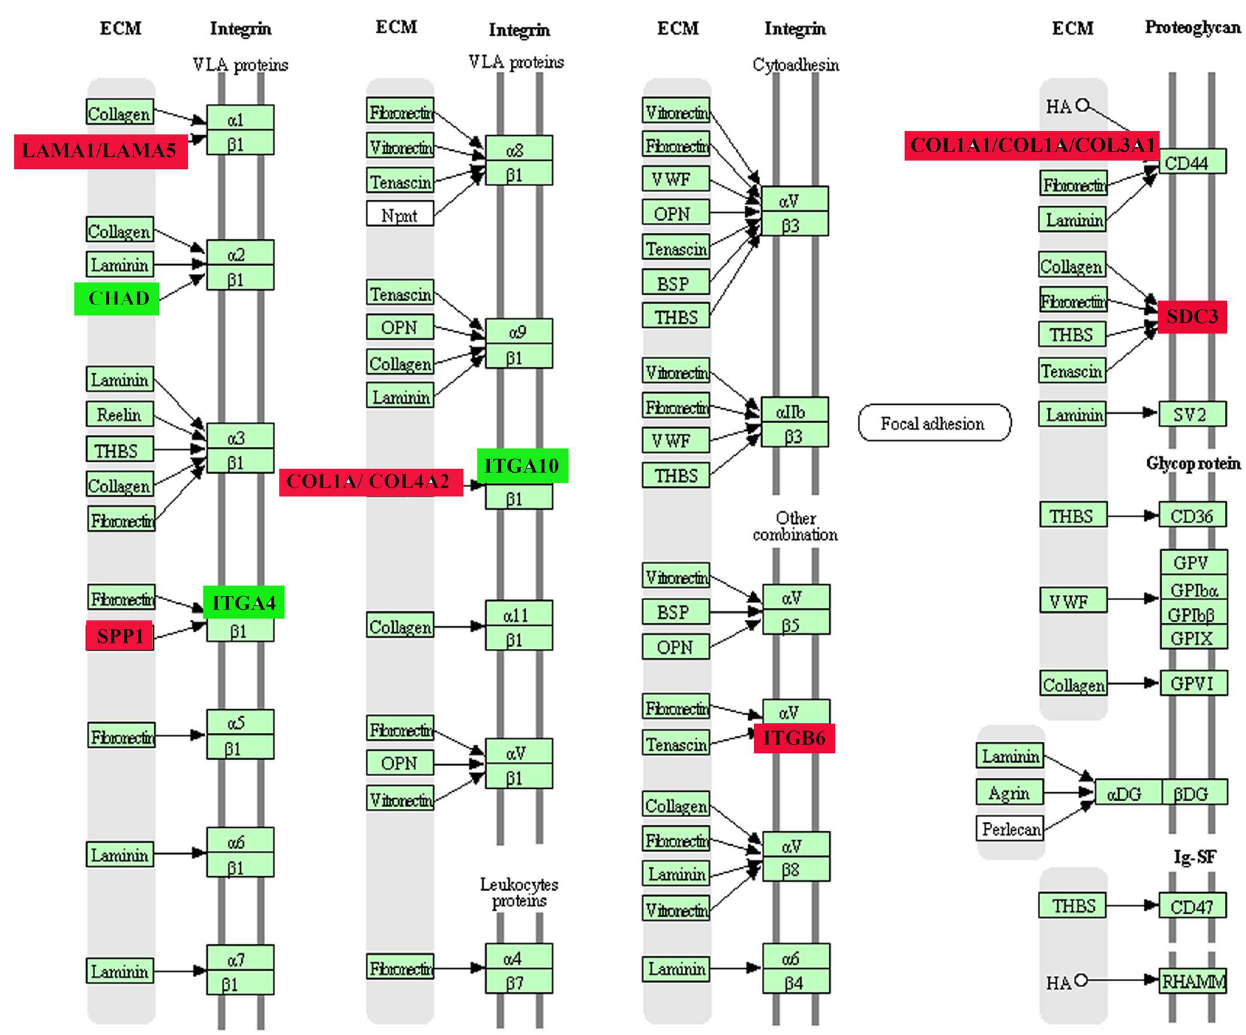
Figure 1. Extracellular matrix interaction signaling pathway. The most significant activate extracellular matrix receptor interaction path diagram of the 7-day stress group compared with the normal group. The red label for the channel of up-regulate genes: ITGB6, COL4A2, SPP1, LAMA1, LAMA5, COL1A1, COL1A, COL3A1, SDC3. The green label for the channel of down-regulate genes: ITGA10, ITGA4, CHAD.